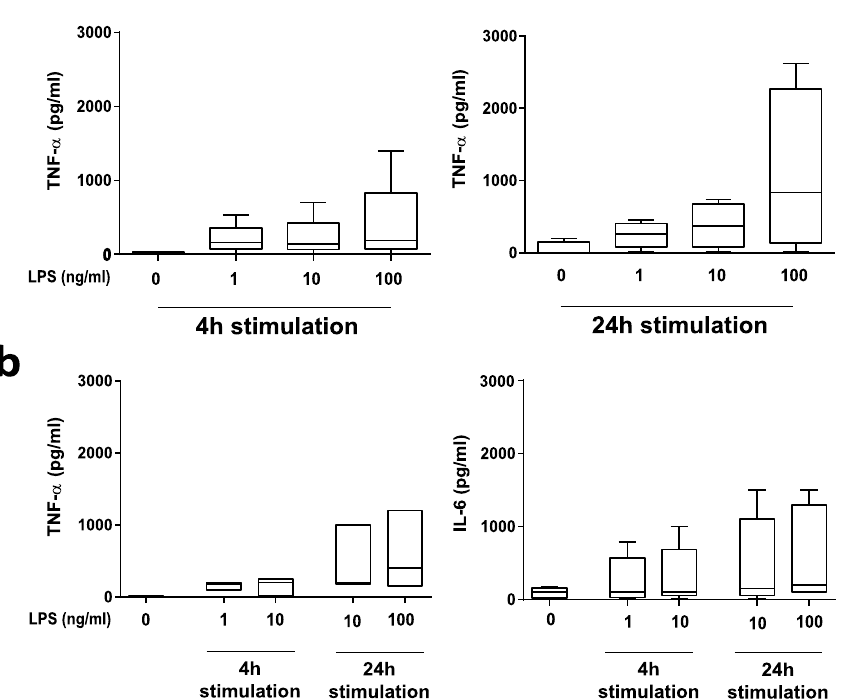
Figure 2. Ex-vivo stimulation assay. Levels of TNF- α and (b only) IL-6 in uncentrifuged PD effluent samples (4 h PET dwell) of 50 ml ( a ) initial cohort, n = 6) or 9 ml ( b ) independent validation cohort, n = 5) in volume, directly stimulated with LPS (0–100 ng/ml) at 37 °C for 4 or 24 h.